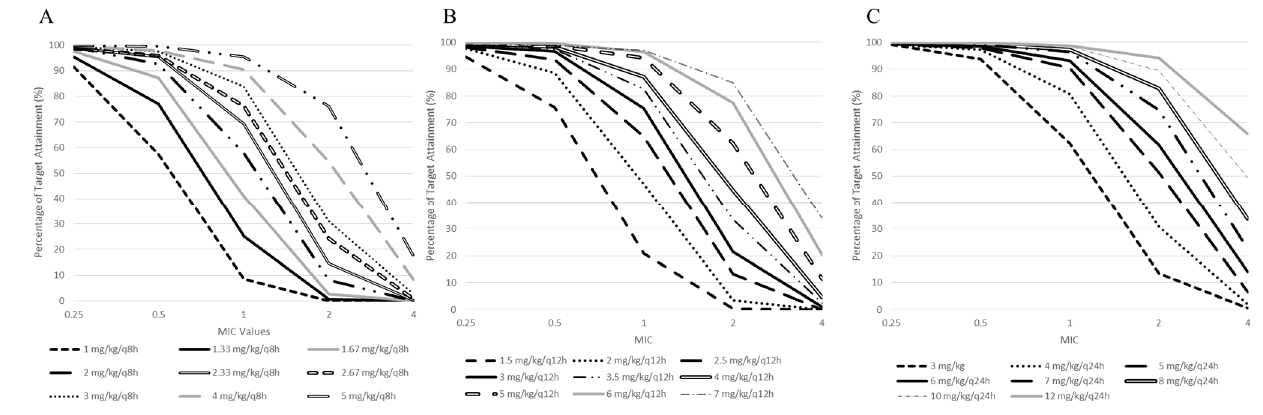
Figure 2. Probability of target attainment of C max /MIC > 8 on the third dose based on different MIC values. ( A ) Dose administered thrice daily (every 8 h). ( B ) Dose administered twice daily (every 12 h). ( C ) Dose administered daily (every 24 h).